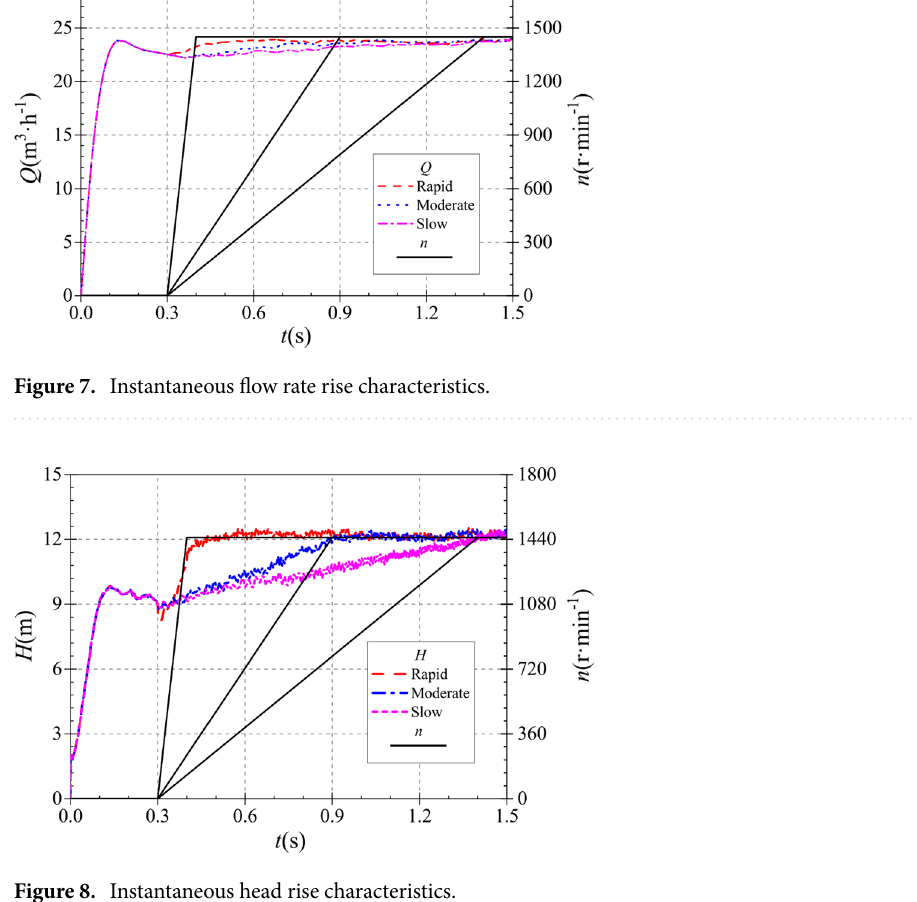
Figure 8. Instantaneous head rise